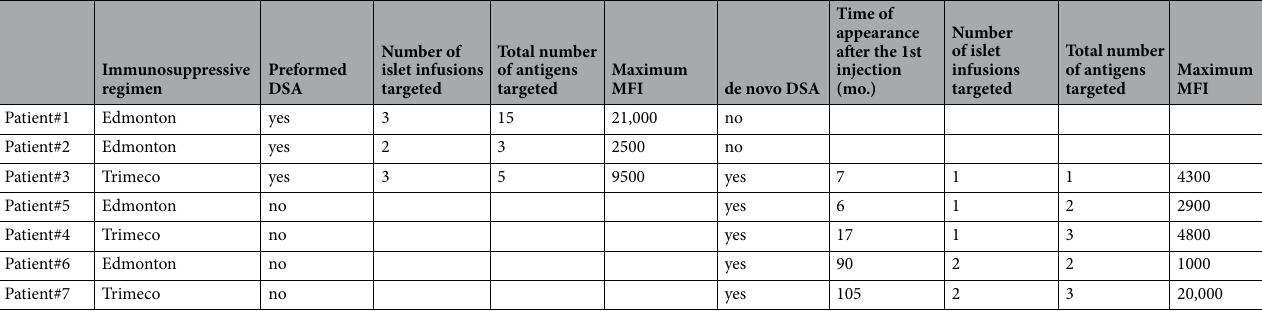
Table 2. Characteristics of HLA Donor-Specific Antibodies in the cohort. DSA Donor Specific-Antibodies, MFI Mean Fluorescence IntensityAdditional supporting information may be found online in the Supporting Information section.